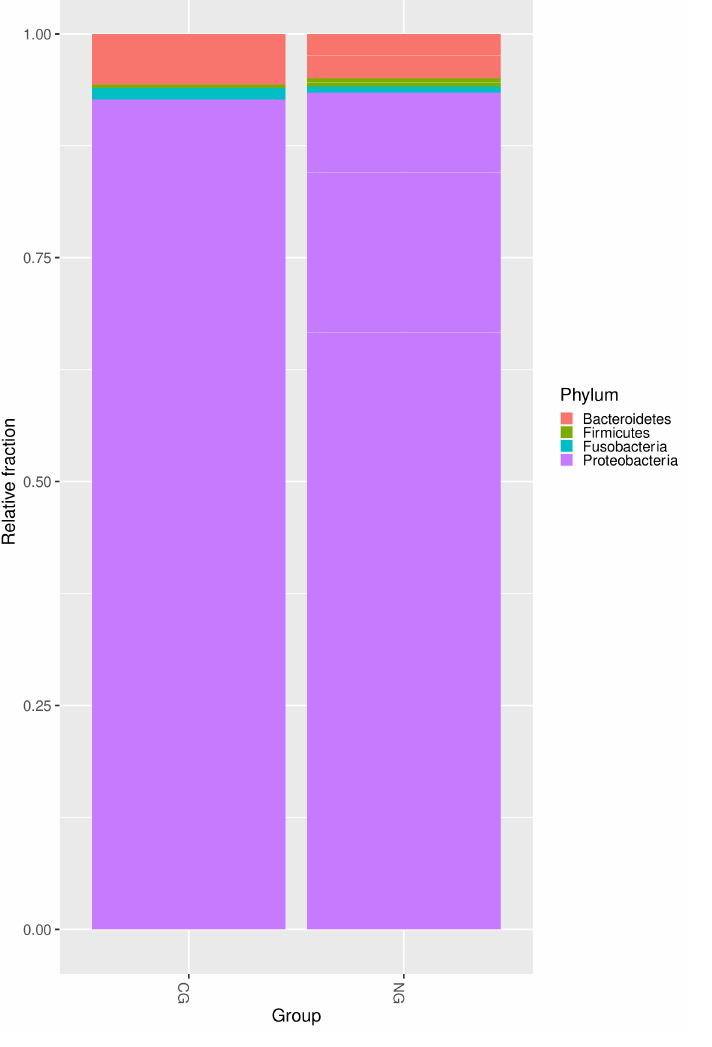
Figure 4. Relative prevalence of the ten most abundant species among the entire microbiome (“Full list”), the subset of species overabundant in the CG patients, and the subset of species overabundant in the